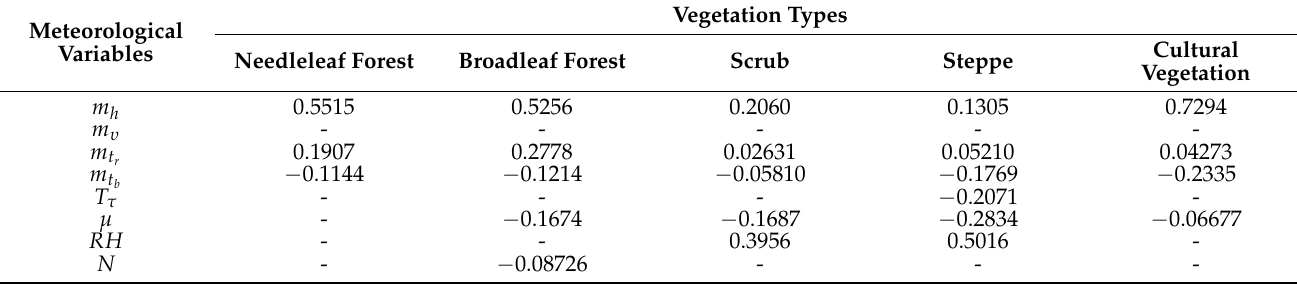
Vegetation Types